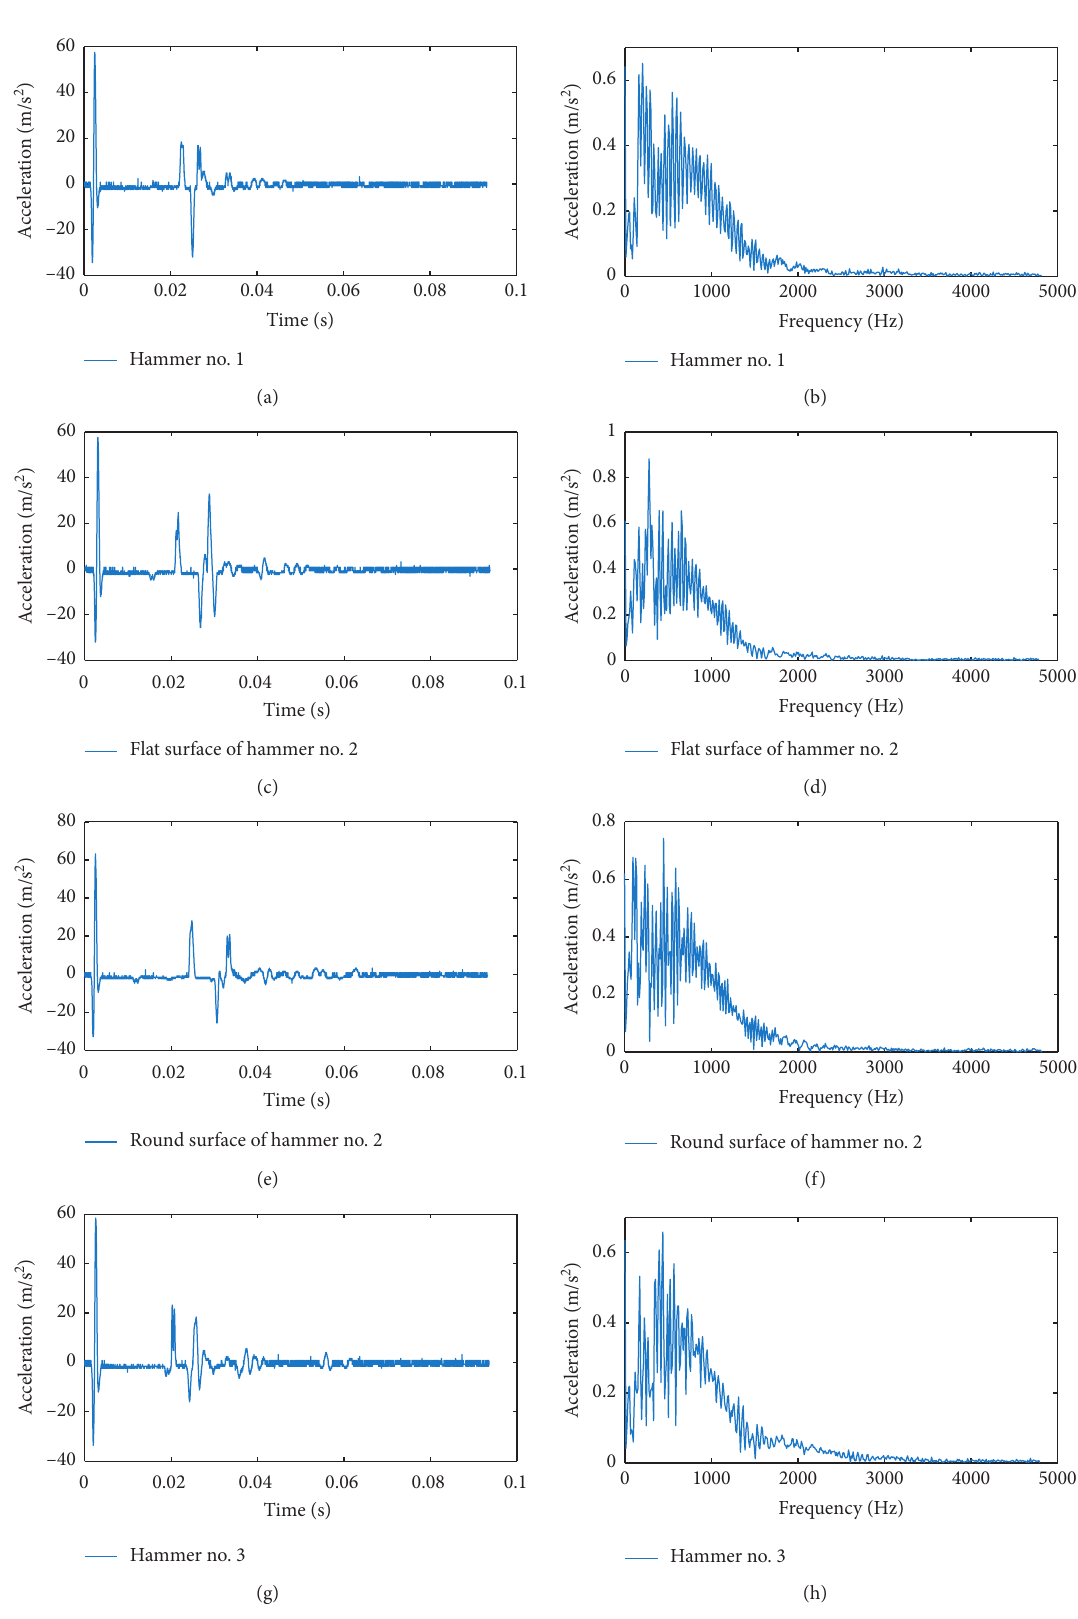
Figure 8: (a, c, e, g) Time-domain waveforms and (b, d, f, h) frequency spectra for different